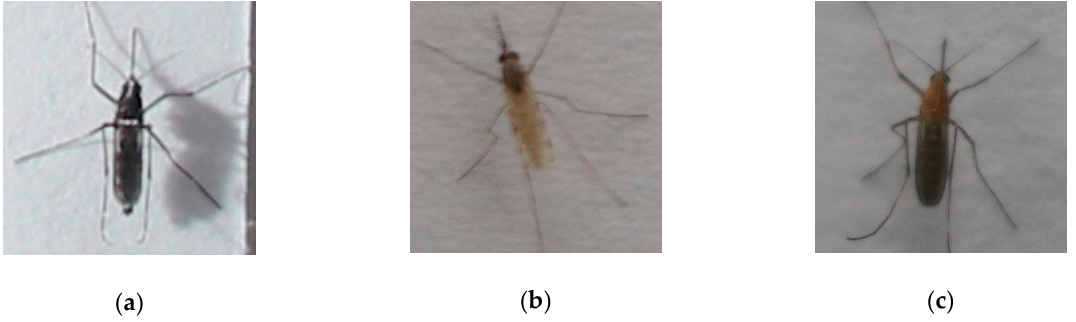
Figure 1. Examples of the captured images: ( a ) Mosquitoes captured using a single-lens reflex camera and ( b ) mosquitoes captured using a smartphone.